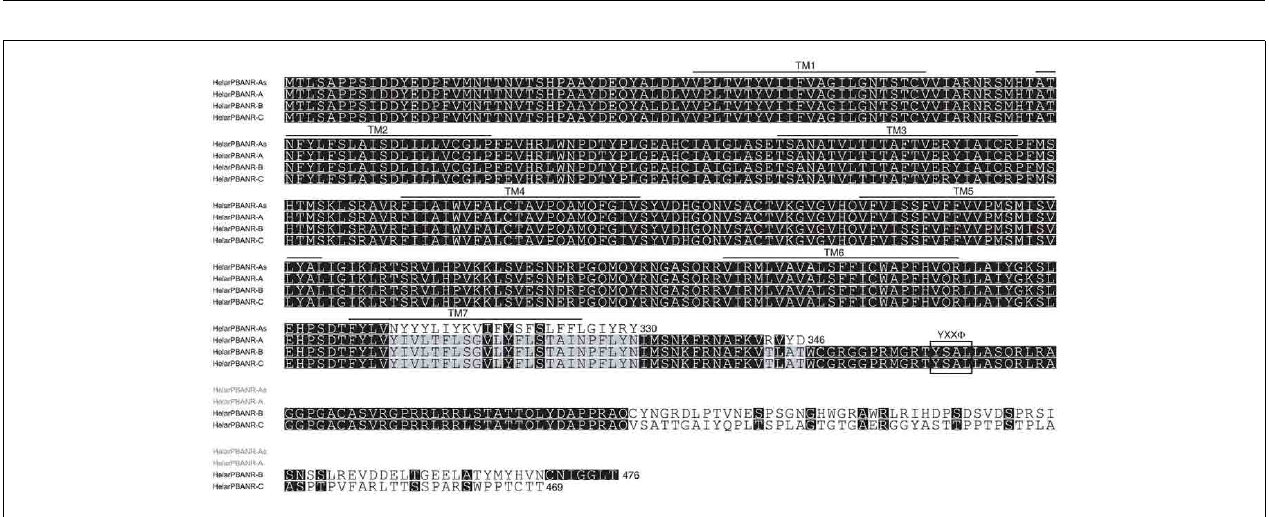
FIGURE 4 | Multiple sequence alignment of the P. separata PBANR variants. The seven predictedTM domains are over-lined. Location of the YXX Φ endosomal sorting motif is outlined. Alignment was performed using